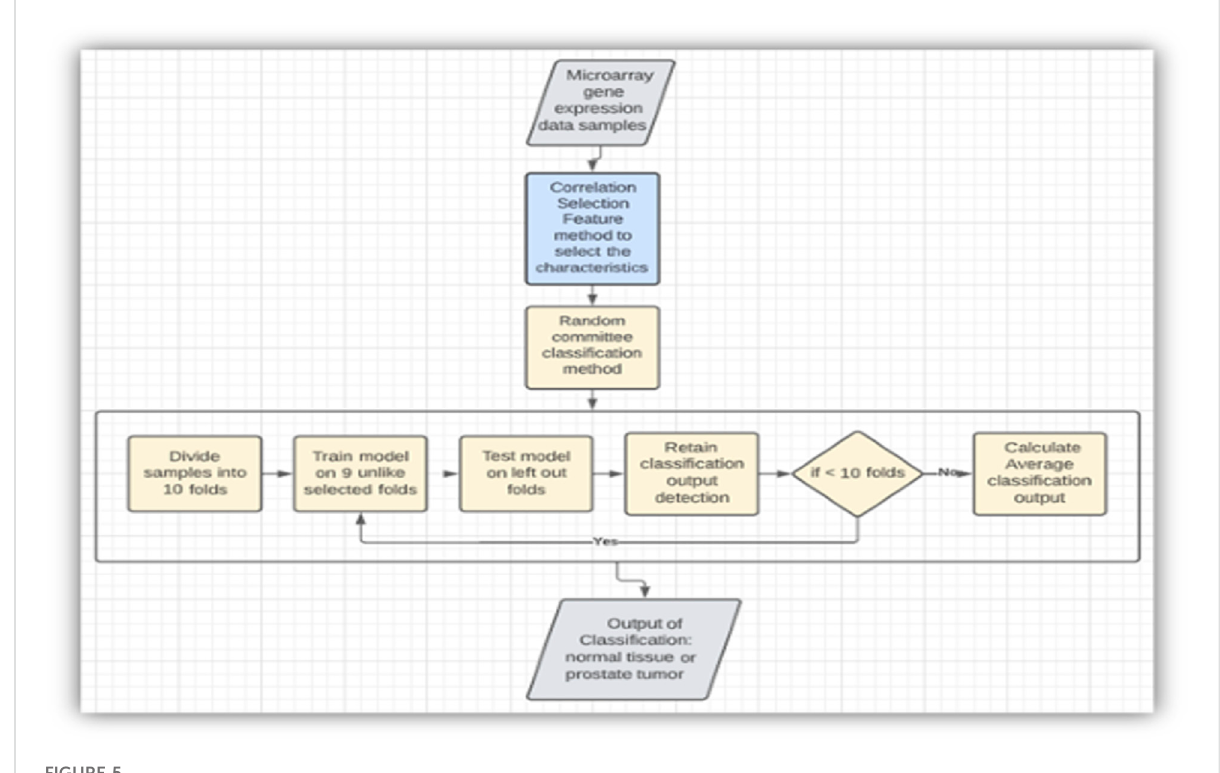
FIGURE 5 Age-standardized rate of patients with prostate cancer